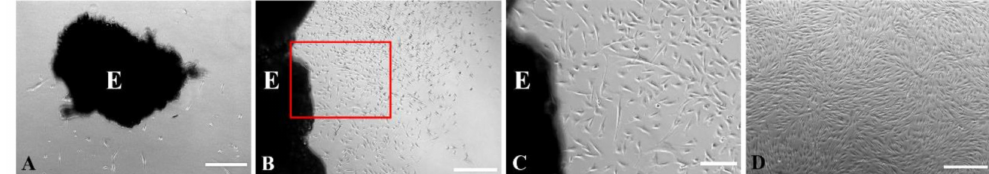
Figure 3. Phase-contrast images of cell migration and expansion from explants. ( A ). The dark area is a dermal explant (E) in 6-well plate at 6-day old culture. 4 × objective. This figure shows the initial cell migration out of explants. ( B ). From the same case, at 11th day more cells were present outside the explant at the same magnification. The red inset area is shown at higher magnification in C. ( C ). Cells exhibited elongated spindle shape cell bodies. 10 × objective. ( D ). A representative image of fibroblasts reaching confluence in P1 subculture. Scale bars in A, B, and D represent 500 µ m and in C 200 µ